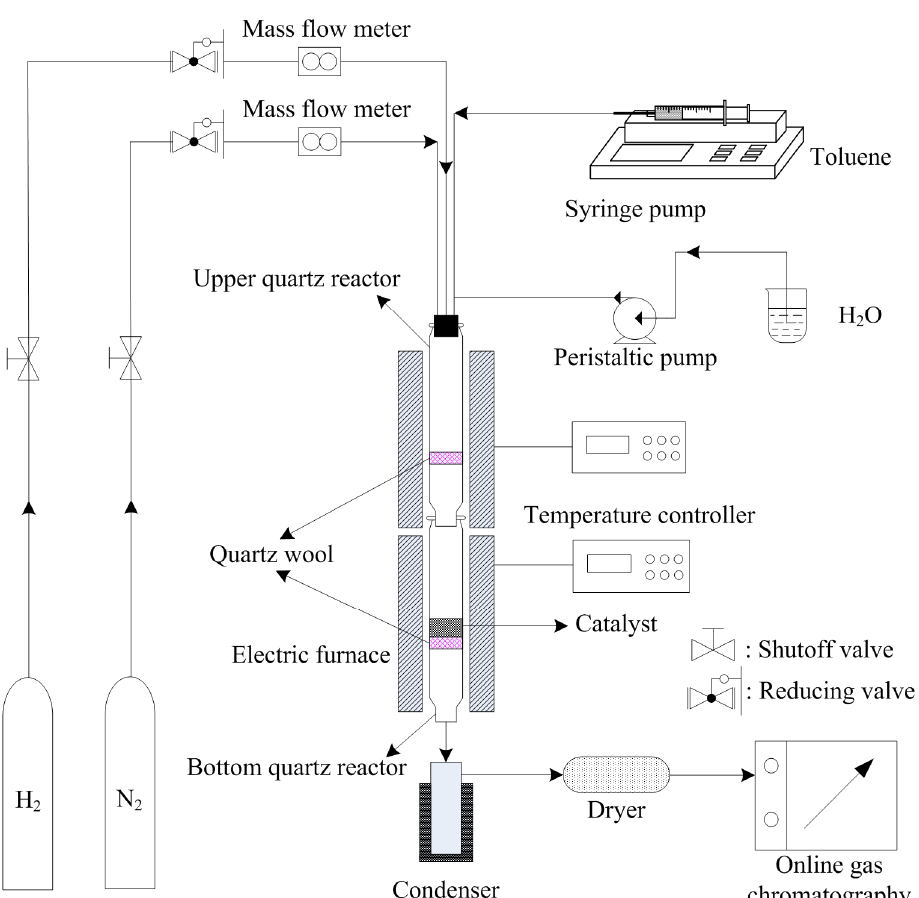
Figure 1. Schematic of the toluene steam reforming